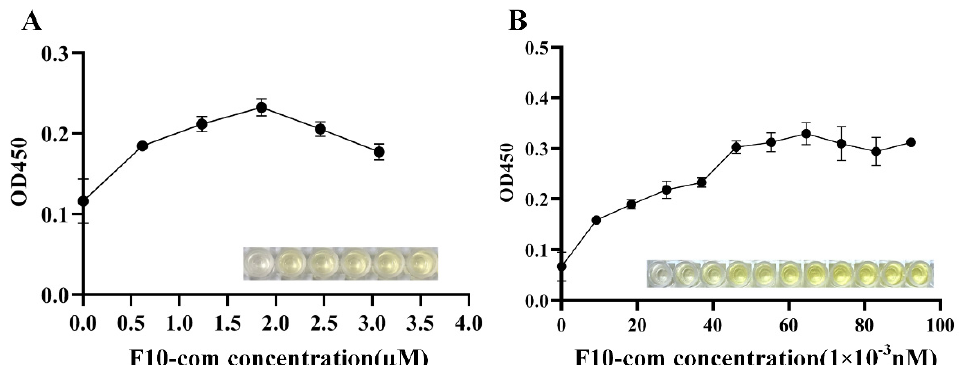
Figure 3. Optimization of experimental conditions. ( A ) Optimization of F10-com concentration. ( B ) Optimization of the addition volume of F10-com-hemin-CDs conjugates.